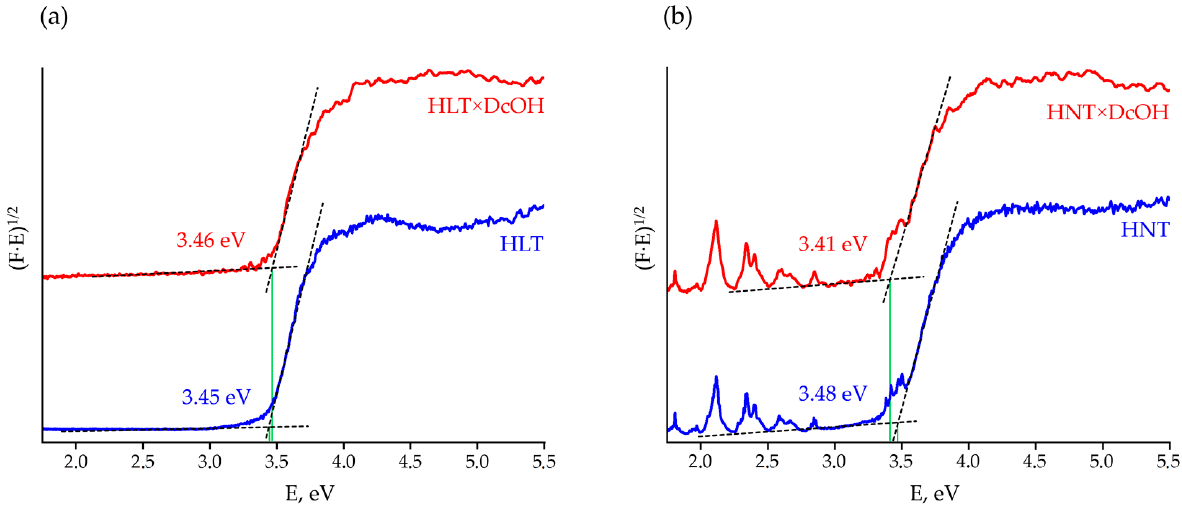
Figure 2. Tauc plots for the initial protonated forms and n -decoxy derivatives of HLT ( a ) and HNT ( b ) titanates.